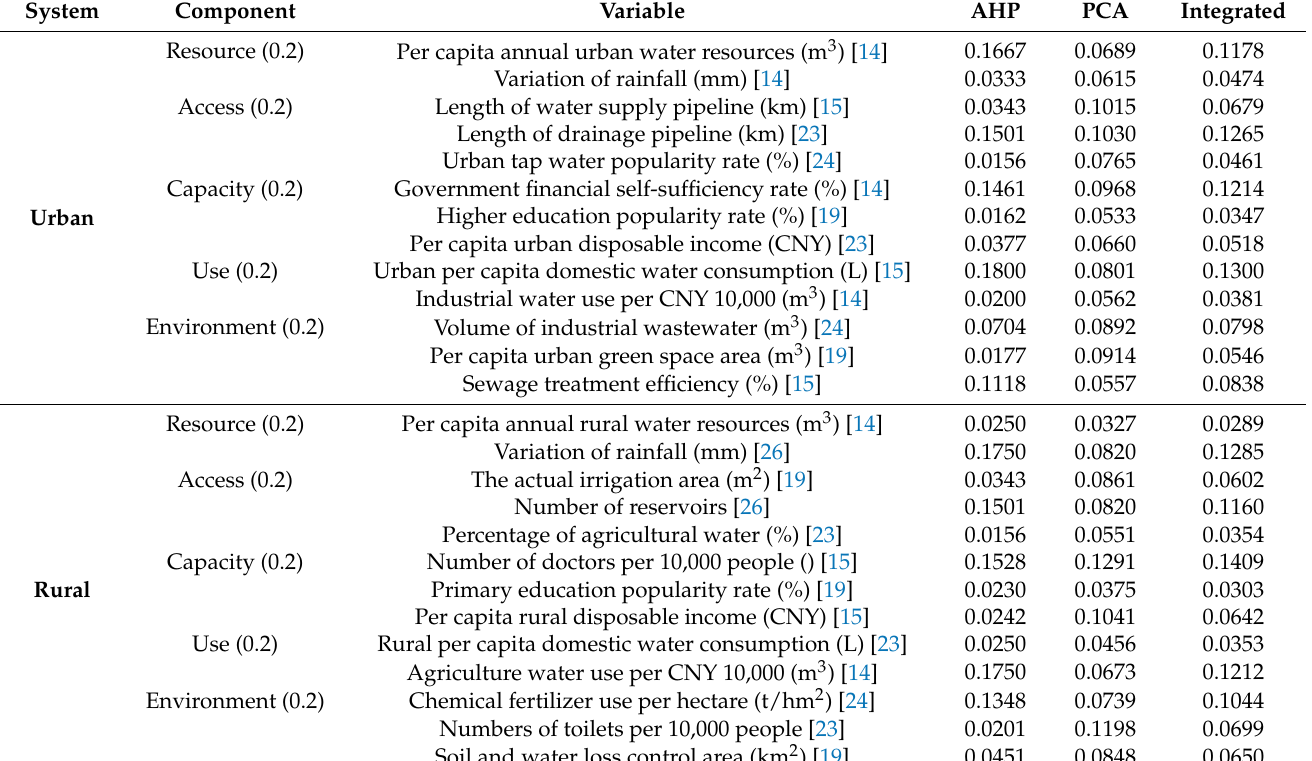
Table 1. Weights of the urban and rural WPI components,